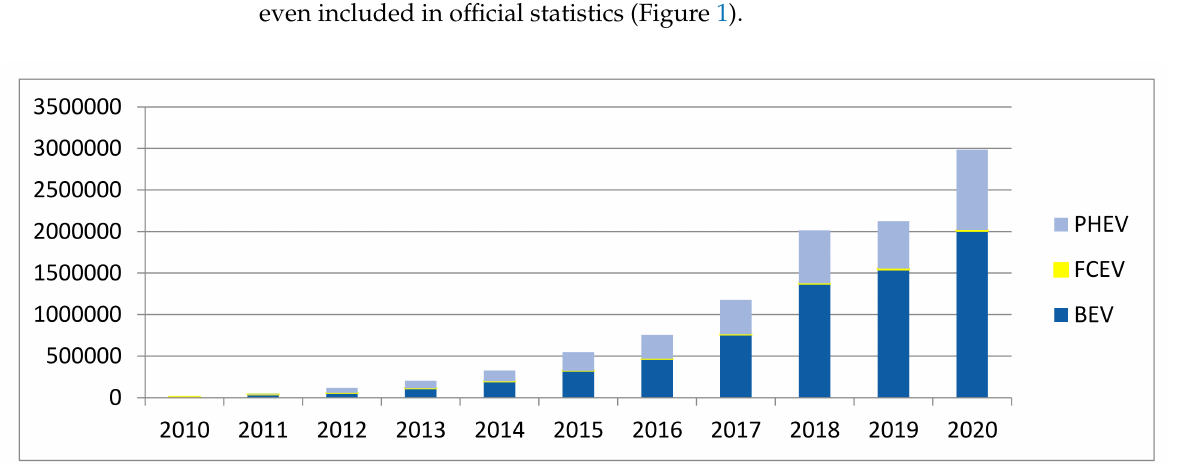
Figure 1. PHEV, BEV, and FCEV sales cars worldwide, 2010–2020. Source: https://www.iea.org/articles/global-ev-data-ex plorer (accessed on 10 October 2021).